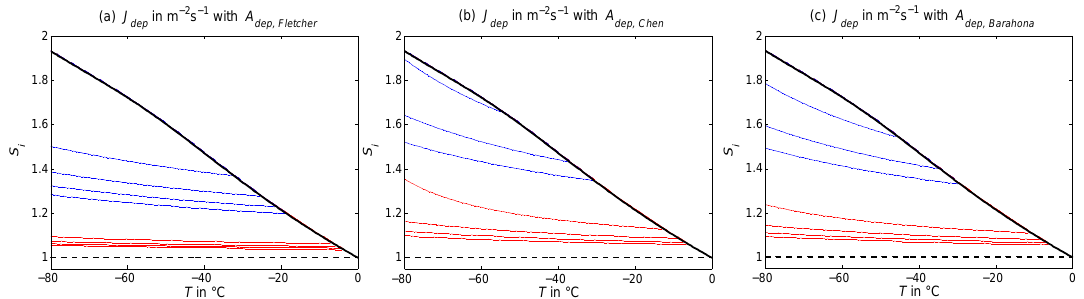
Fig. A1. Deposition nucleation rates calculated from classical nucleation theory, with different formulations of the kinetic factor A dep : (a) Fletcher (1958), (b) Chen et al. (2008), and (c) Barahona (2011). The red lines are valid for f het = 0 . 0005, and the blue lines for f het = 0 . 01. From bottom to top, the isolines correspond to j dep = 1 , 1 × 10 6 , 1 × 10 12 , and (beyond the plotting range for the blue lines in b and c )